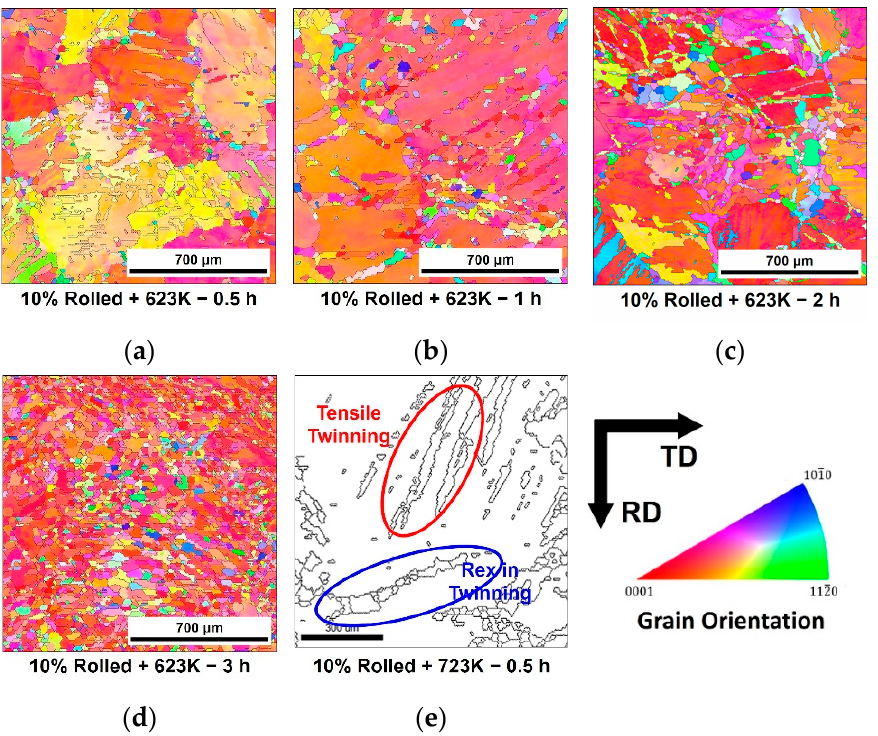
Figure 4. Microstructures of the specimens after rolling with the 10% reduction and annealing at 623 K for ( a ) 0.5, ( b ) 1, ( c ) 2 and ( d ) 3 h and ( e ) at 723 K for 0.5 h.